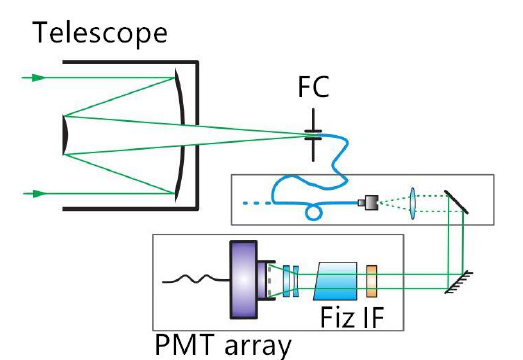
Fig. 1. Setup principle of an imaging high spectral resolution temperature receiver by using a Fizeau interferometer.